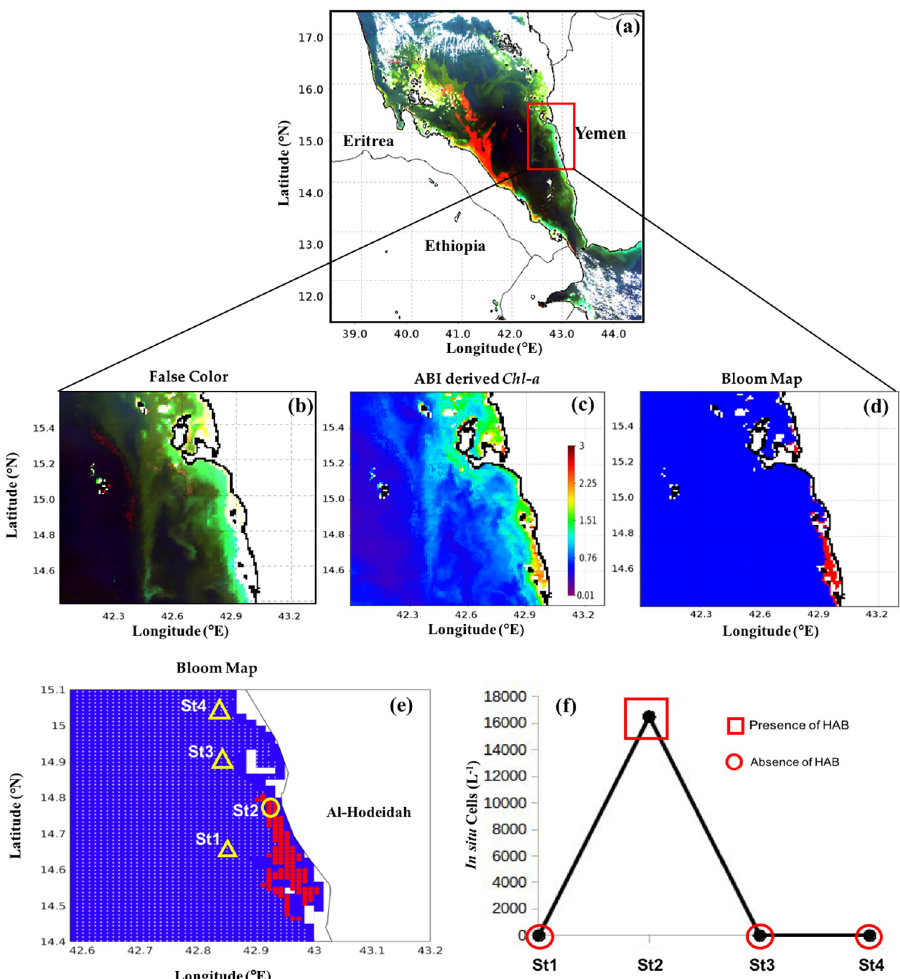
Fig 9. Remotely sensing T . erythraeum blooms in the southern Red Sea and comparison with in situ measurements. (a) and (b) False color composite image generated using the NIR, green and blue reflectances (i.e., R = R rs (748), G = R rs (547), B = R rs (443)). (c) Satellite-derived Chl-a using ABI algorithm. (d) and (e) MODIS-Aqua- derived maps of the T . erythraeum blooms in the Red Sea on 27 th December 2012 [In (e) the red and white dots denote the presence and absence of HABs, respectively, as detected using satellite data. Also, the yellow circle and yellow triangles indicate the in situ sample points and highlight the presence and absence of T . erythraeum blooms, respectively]. (f) Variations in T . erythraeum cell counts recorded from the four different sampling stations in the Yemeni coastal waters off Red Sea, near Al Hodeida City on 27 th December 2102 [red squares and red circles denote satellite detection of HAB presence and absence,